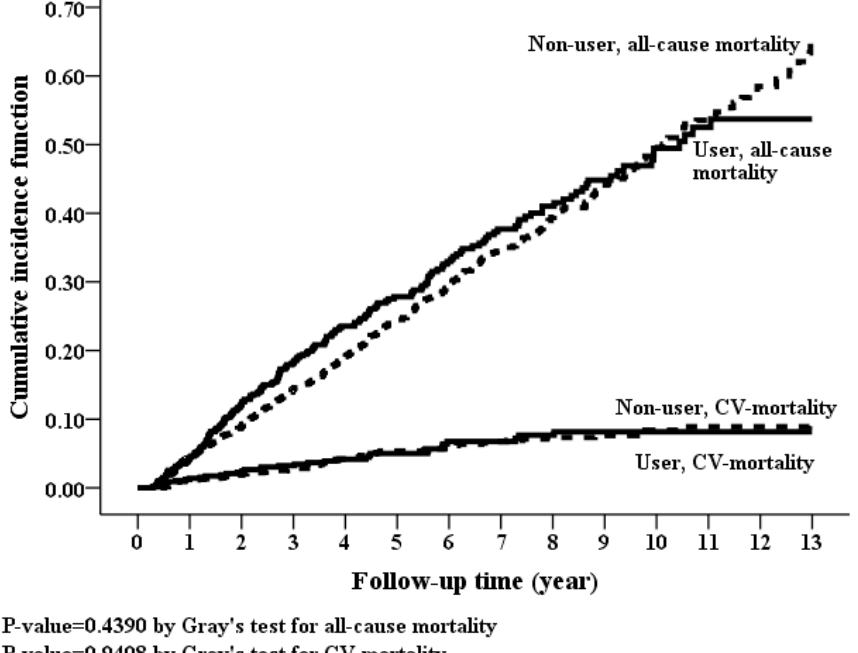
Figure 5. Cumulative incidence rate of all-cause mortality ( p -value = 0.439, Grey’s test) and cardiovascular disease-mortality ( p -value = 0.9408, Grey’s test) between spironolactone users and non-users.